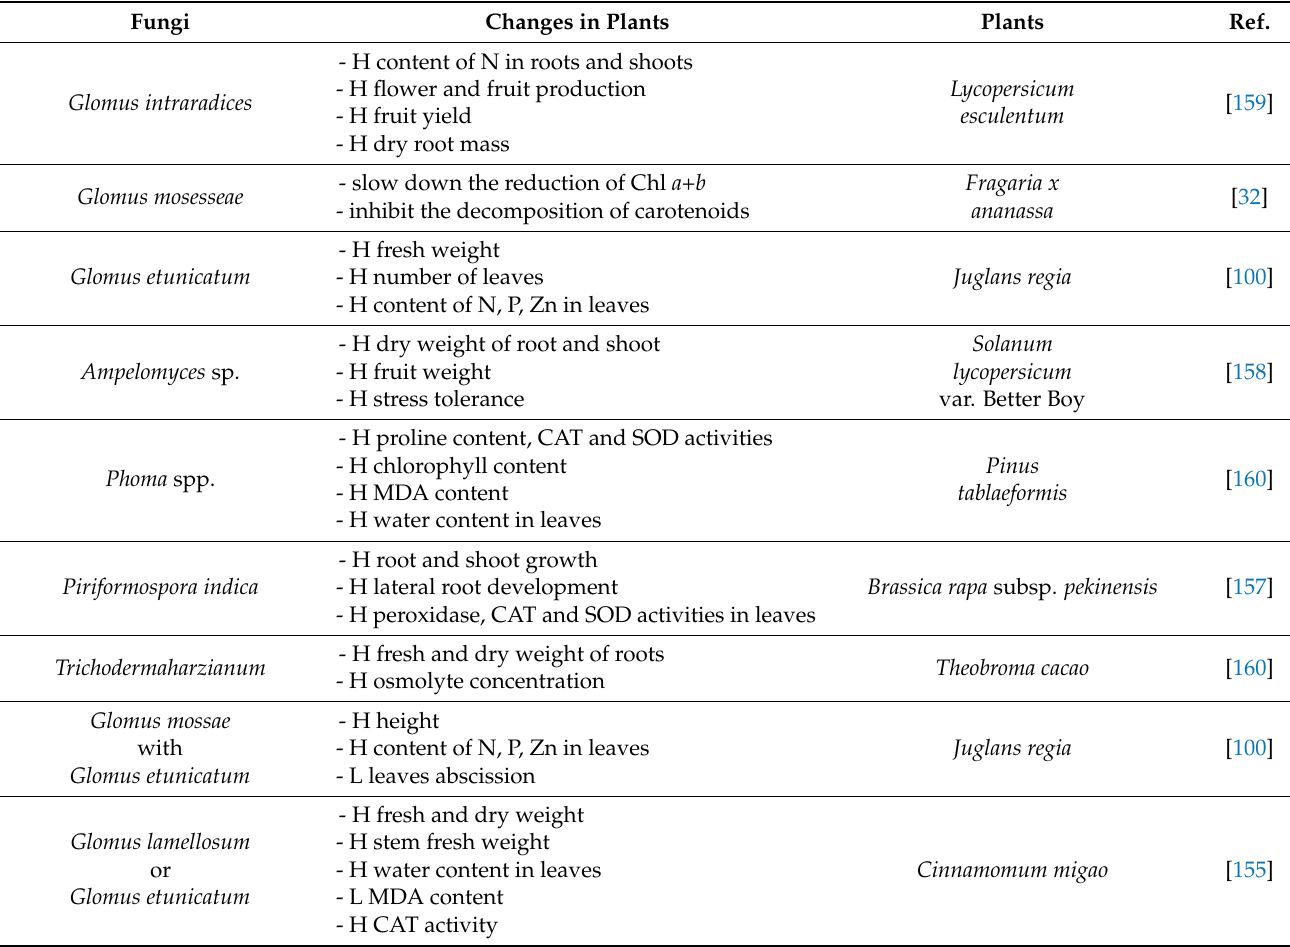
Table 2. Selected activities of beneficial fungi under drought stress conditions in horticultural plant species; H—higher level/content; L—lower level/content; Chl—chlorophyll; CAT—catalase; SOD—superoxide dismutase; MDA—malondialdehyde. Fungi Changes in Plants Plants